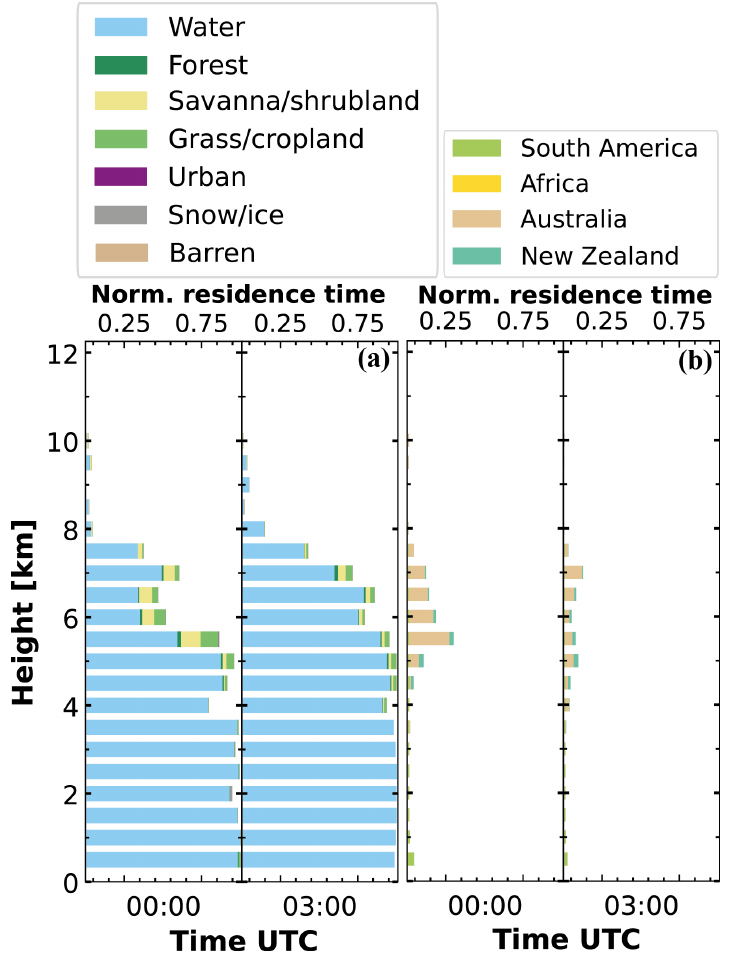
Figure 8. Same as Figure 4 but for 11 March